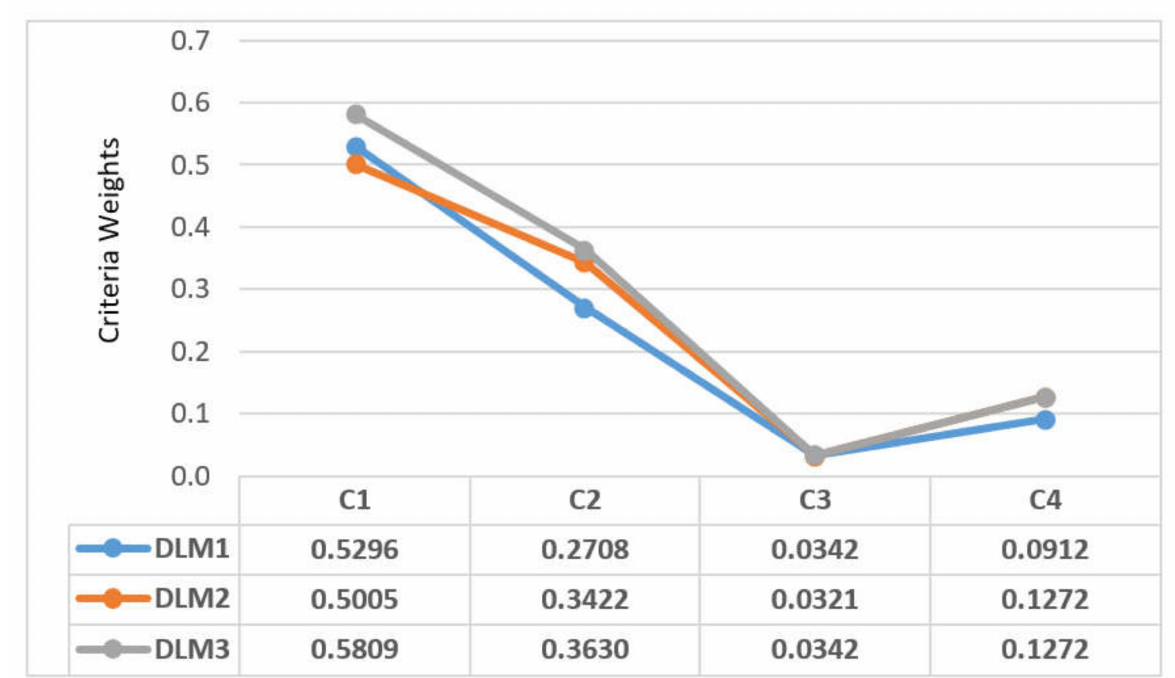
Figure 3. The study results of quality assessment for three distance learning modules—DLM1, Research methodology and statistical analysis; DLM2, Social Statistics; and DLM3, Political Science Research Methodology—by four criteria according to military students’ opinion: C 1 = the professionalism of the lecturer; C 2 = assistance to students in the learning processes; C 3 = organization of individual learning with feedback; C 4 = practical benefits of the course for the